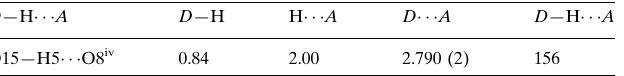
Hydrogen-bond geometry (A˚ , (cid:3)